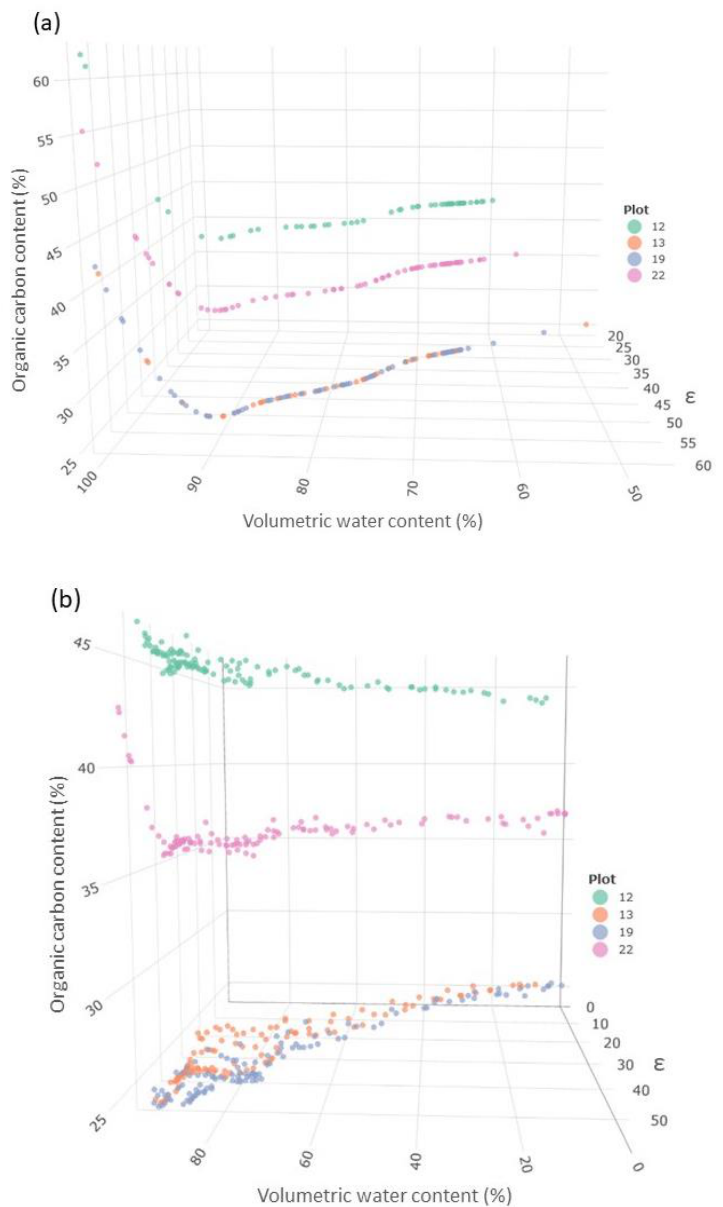
Figure 4. 3D plot of the organic carbon (OC) model outputs from ( a ) the water content and von Post (WKvP) model, and ( b ) the water content with von Post under inclusion of impedance (WKvPI) model. The y-axes indicate the modelled OC contents, while the x-axes show the corrected volumetric water content in %. The z-axes show the dielectric permittivity ( ε ). Coloured dots indicate different plots, each comprising the four replicates per plot. All 3D plots are available as an interactive version online (link in supplementary material).